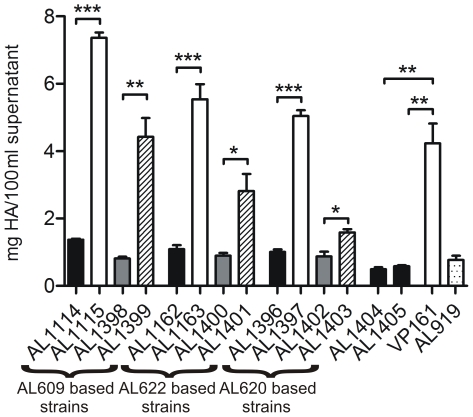
Hyaluronic acid (HA) capsular polysaccharide produced by P. multocida strains.The amount of capsular material is shown for paired acapsular (AL1114, AL1162 and AL1396) and capsulated (AL1115, AL1163 and AL1397) variants and the same strains complemented with either empty vector (AL1398, AL1400 and AL1402) or an intact copy of fis (AL1399, AL1401 and AL1403). Brackets below the figure indicate strains derived from the same parent strain. Also shown is the amount of HA produced by the TargeTron fis mutants AL1404 and AL1405, the wild-type encapsulated parent strain VP161 and the hyaB capsule mutant AL919. Results for experimentally related strains are shaded similarly with black bars representing fis mutants, white bars representing parent and wild-type strains, hatched bars representing the fis complemented strains, gray bars representing strains transformed with vector only and the dotted bar representing the directed hyaB mutant. Each bar represents triplicate values ±1 standard error of the mean (SEM) *** p<0.001, ** p<0.01, * p<0.05.